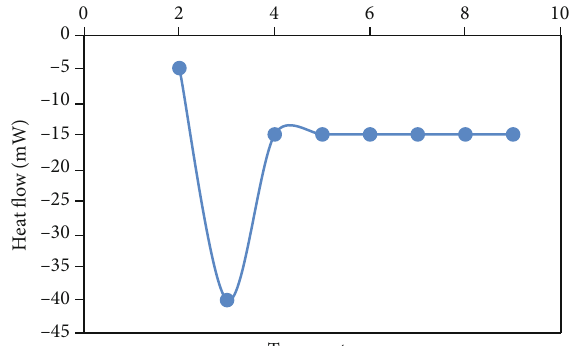
Figure 2: Thermal energy storage.